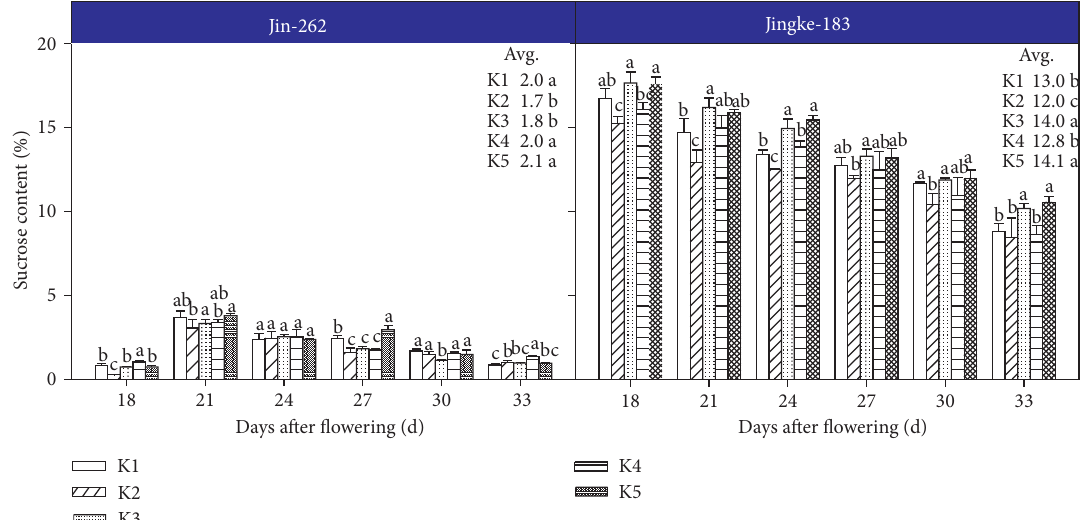
Figure 3: Effects of potassium on the grain sucrose content of fresh-eaten maize kernels. The different lowercase letters are significant differences at the 5% level; AVG, average; the bars are standard deviation ( n � 5).